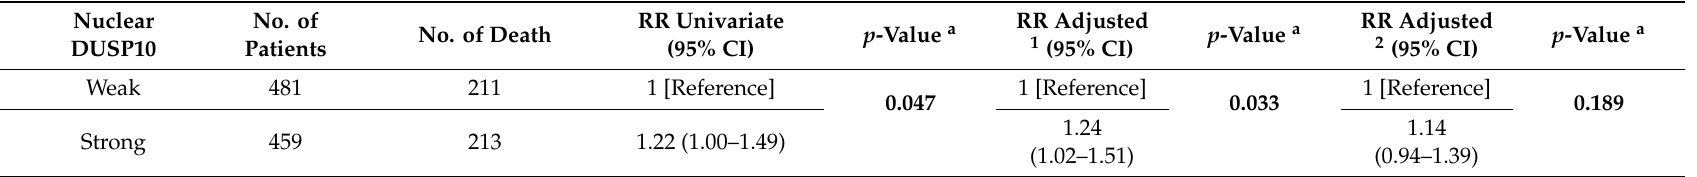
Table 3. Survival analysis of colon cancer patients depending on nuclear DUSP10 protein expression. A cohort of 999 colon cancer patients was analyzed and classified by weak and strong staining for DUSP10. Number of events (deaths per group) were quantified. The table represents the relative hazard ratio (RR) and 95% confidence interval